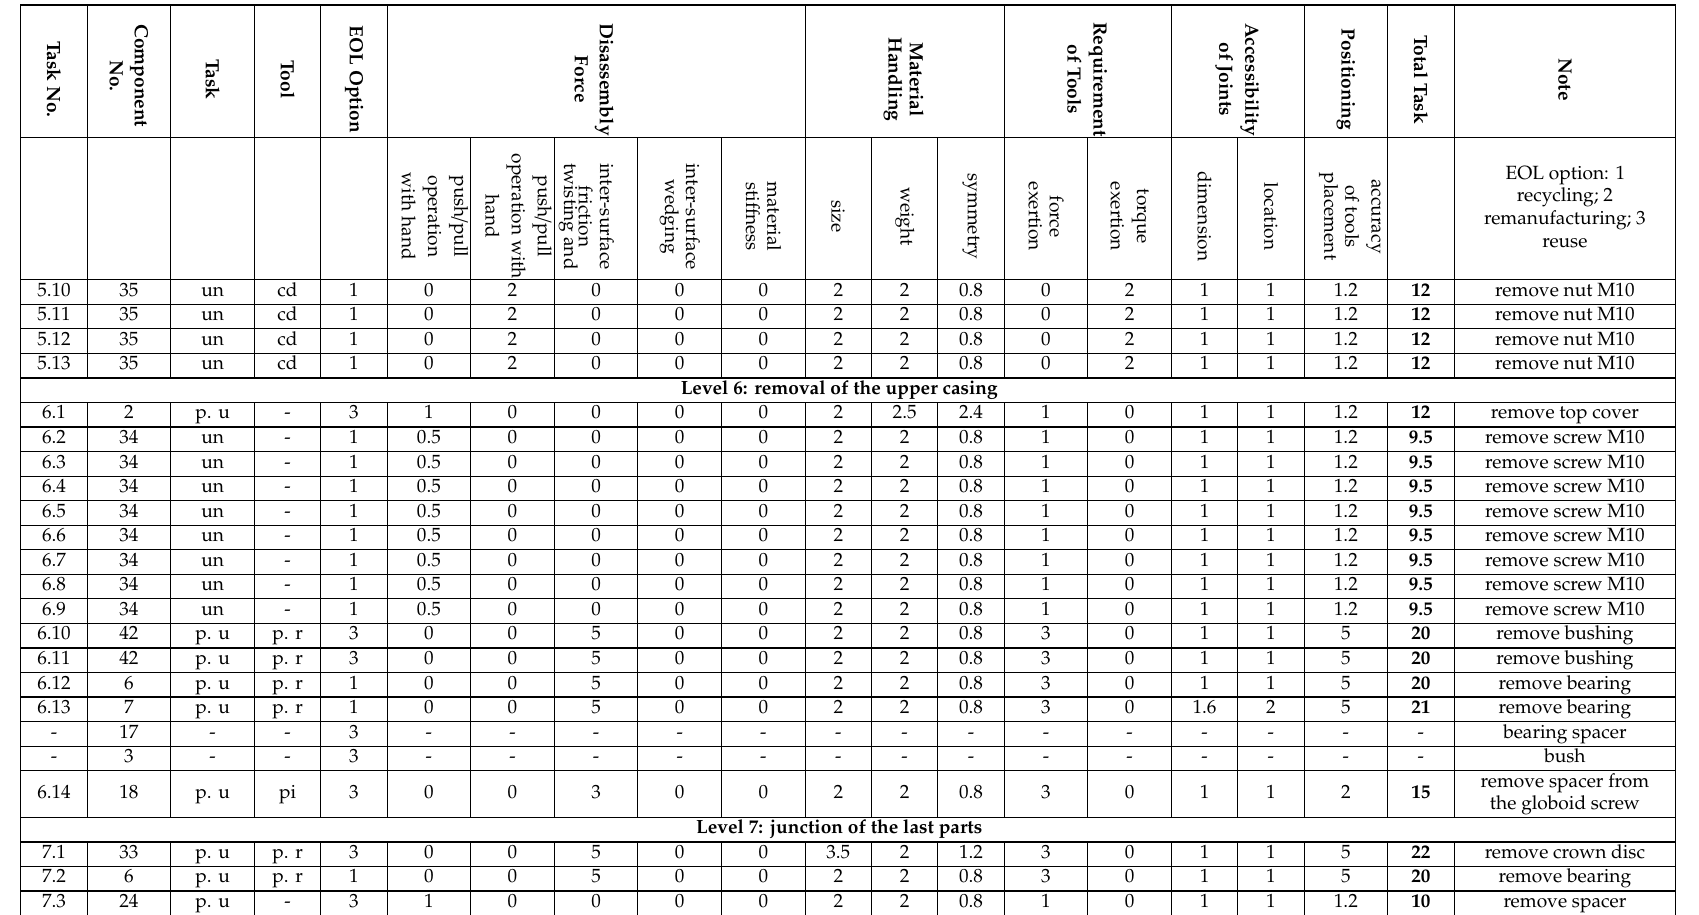
Level 7: junction of the last parts